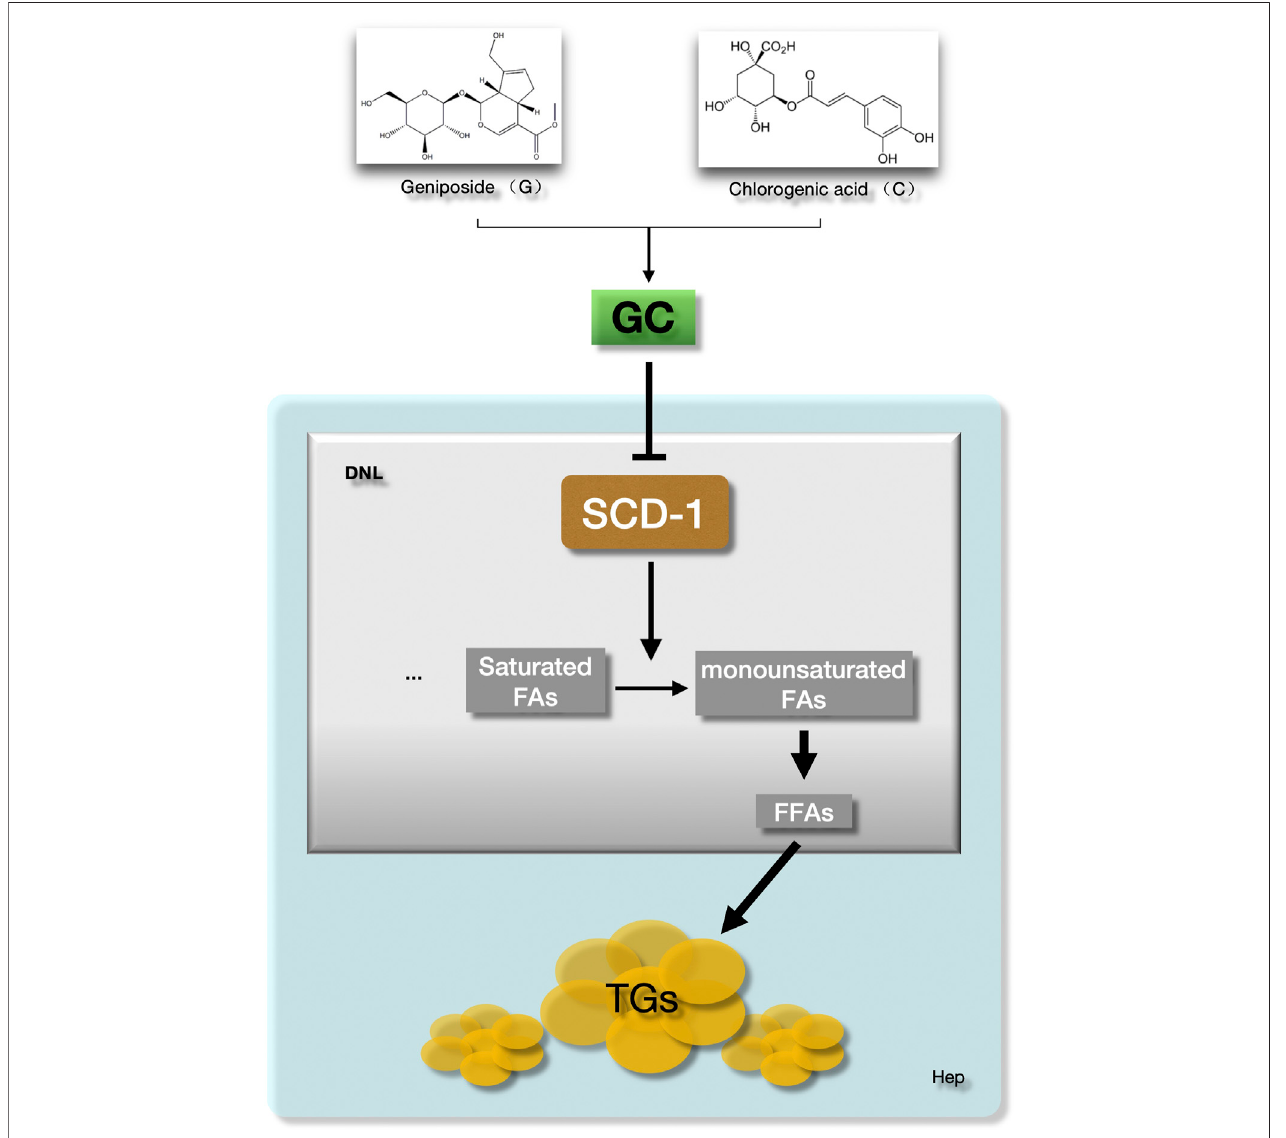
FIGURE7| The GCcombination ameliorateshepatic fatdepositionbysuppressing SCD-1.SCD-1promotesthelast stageof denovo lipogenesistoform thefree fatty acid in hepatocytes. The GC combination was demonstrated to suppress the hepatic SCD-1expression, which highly impairs the DNL process and further attenuate the hepatic lipid deposition in NAFLD models. GC, Geniposide and chlorogenic acid combination, SCD-1, Stearoyl CoA desaturase-1, DNL, de novo lipogenesis, FFAs, Free fatty acids, TGs, Triglycerides.